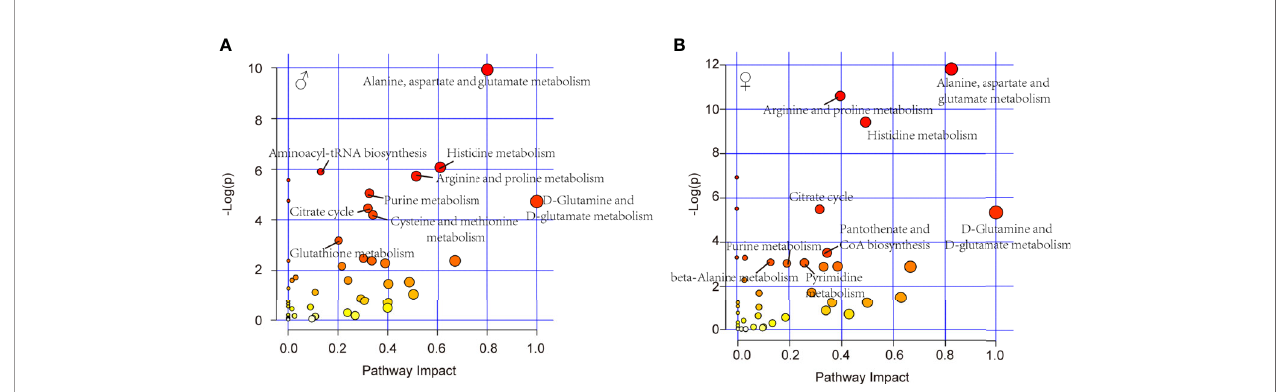
FIGURE 4 | Relevant pathways of differential metabolites affected by intrauterine hyperglycemia. (A) Different metabolic pathway in GDM-F1 male fetal pancreas. (B) Different metabolic pathway in GDM-F1 female fetal pancreas. Each bubble represents a metabolic pathway and its size is related to the impact of the pathway, with color demonstrating the signi fi cance from highest (red) to lowest (white).